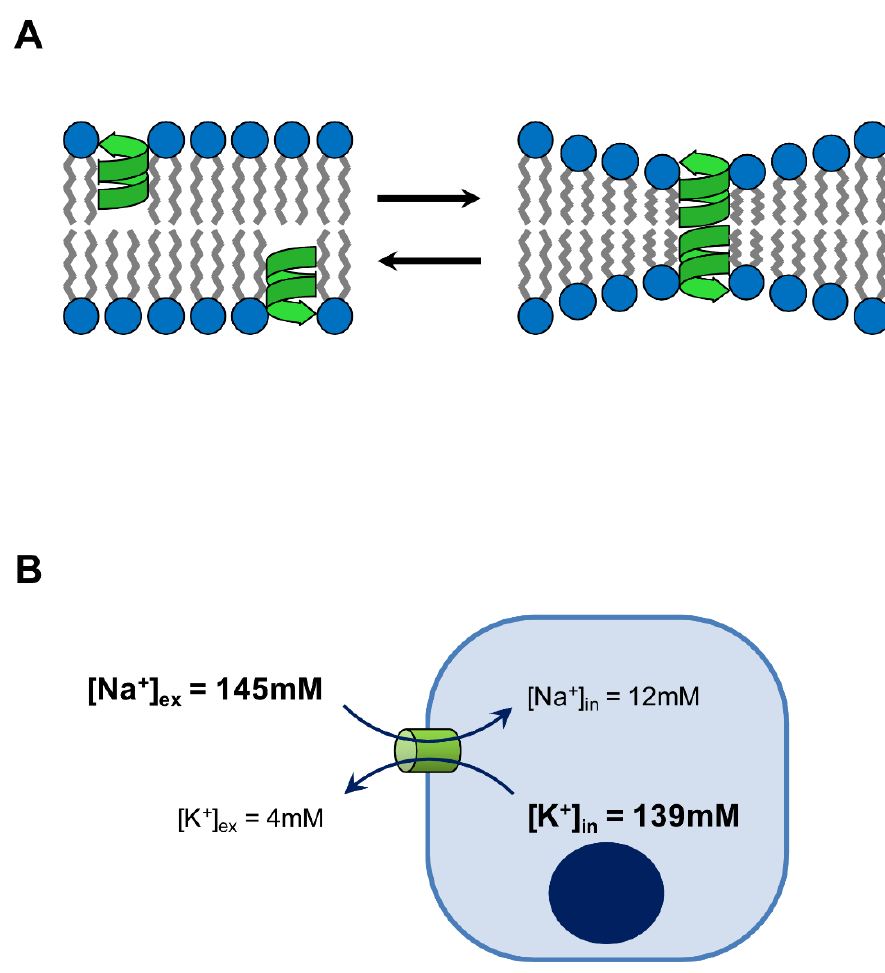
Figure 1. Mechanism of action of gramicidin A. (A) Gramicidin monomers form a β-helix conformation within membranes. Dynamic dimerization of two monomers forms the functional channel, which consequently induces local membrane deformation. (B) Cells maintain a low concentration of intracellular Na+ and a high concentration of intracellular K+ relative to the extracellular environment. Formation of the gramicidin channel (green cylinder) upsets this balance by permitting the passive diffusion of these cations along their respective concentration gradients (arrows) resulting in Na+ influx and K+